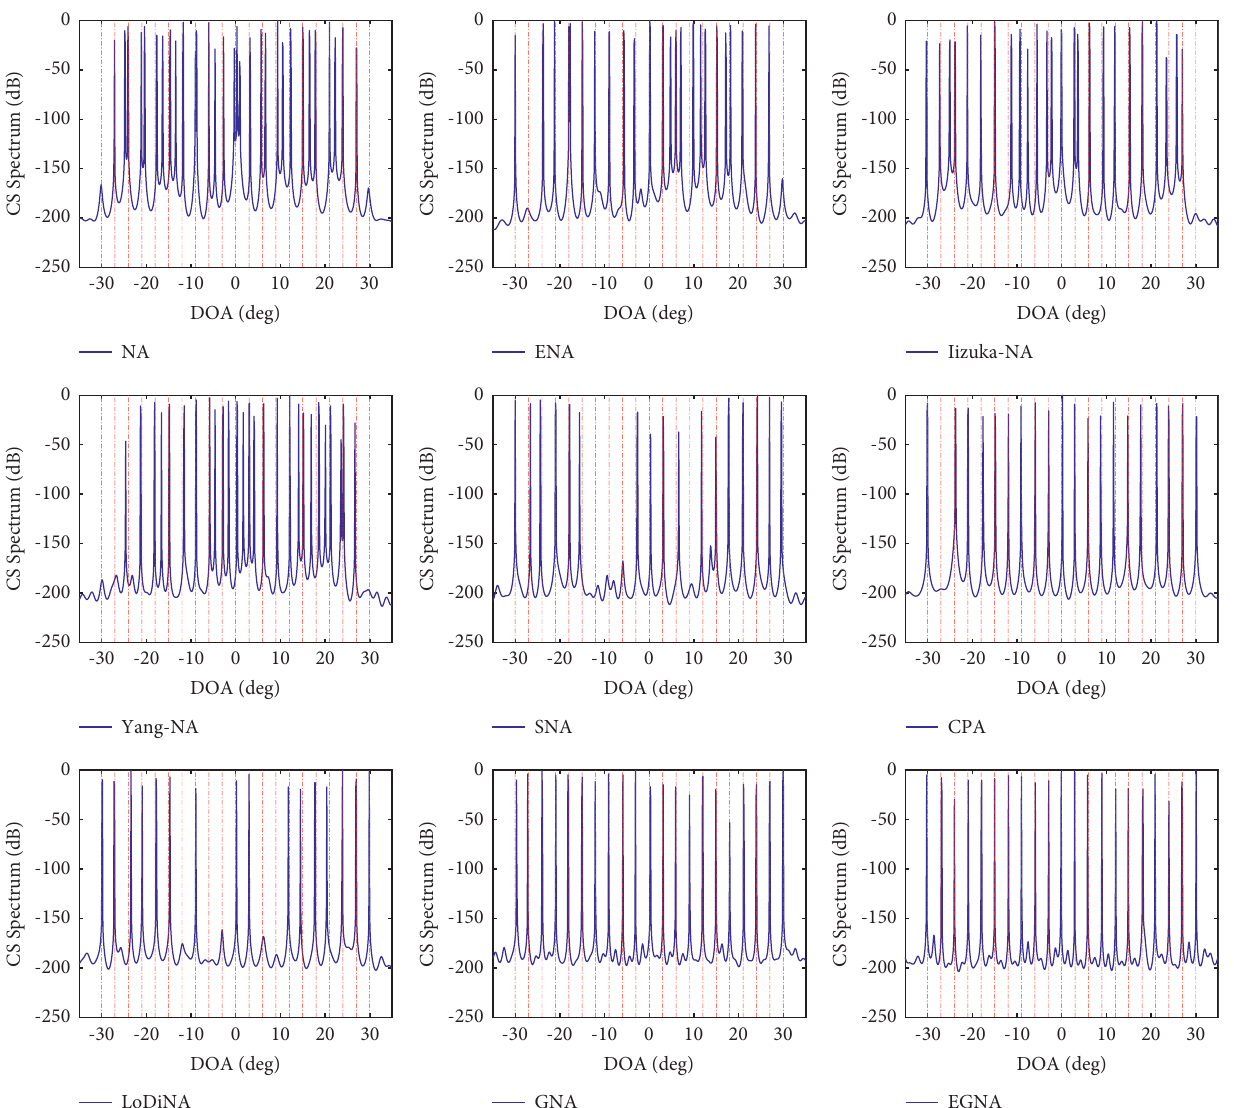
Figure 9: Comparison of CS spectrum for different array